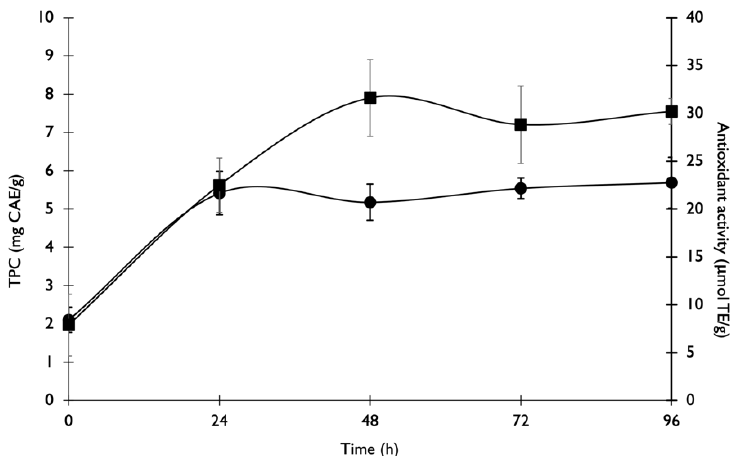
Figure 5. Variation of phenolic compounds ( ● ) and antioxidant activity ( ■ ) after sequential SSF and ET.